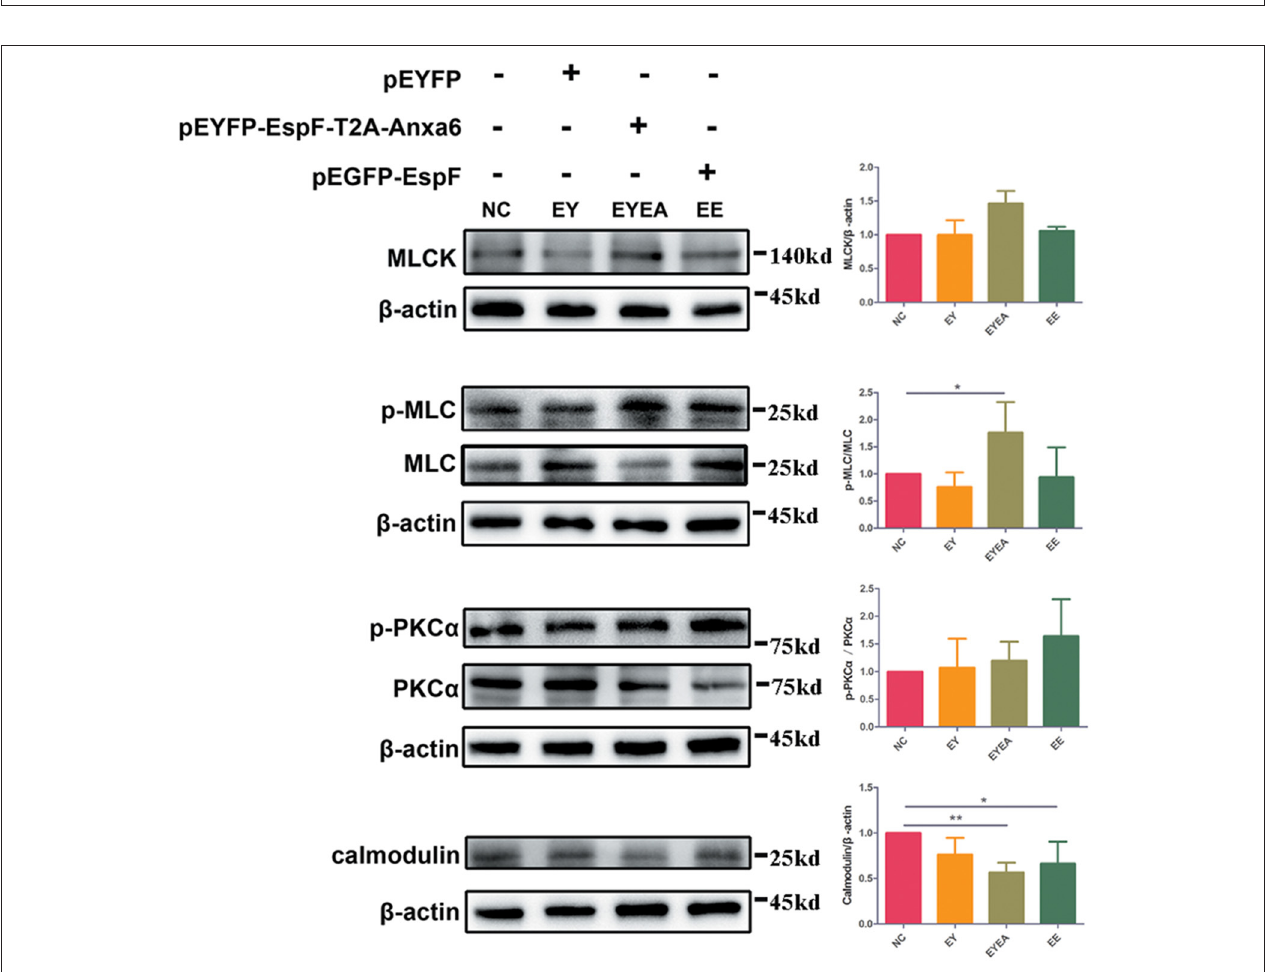
FIGURE 5 | software. Error bars represent means ± SD from three independent experiments. (C,D) Immunofluorescence and quantification analysis of ZO-1 protein. Nucleus was labeled with Hoechst in blue. ZO-1 was labeled with anti-ZO-1 antibody in red. Green indicates fluorescence expressed by the fluorescent plasmid. Images were acquired on an FV1000 confocal laser scanning microscope using a 60X oil objective. The fluorescence intensity of ZO-1 was analyzed by ImageJ software. Error bars represent means ± SD from three independent experiments. *Statistically significant difference. * p < 0.05. *** p < 0.001. (E) Immunofluorescence of ANXA6 protein in Caco-2 cells. As described in (C,D) ANXA6 was labeled with an anti-ANXA6 antibody in red. Images were acquired on an FV1000 confocal laser scanning microscope using a 60X oil objective. NC, non-transfected cells; EYEA, cells transfected with pEYFP-EspF-T2A-ANXA6.